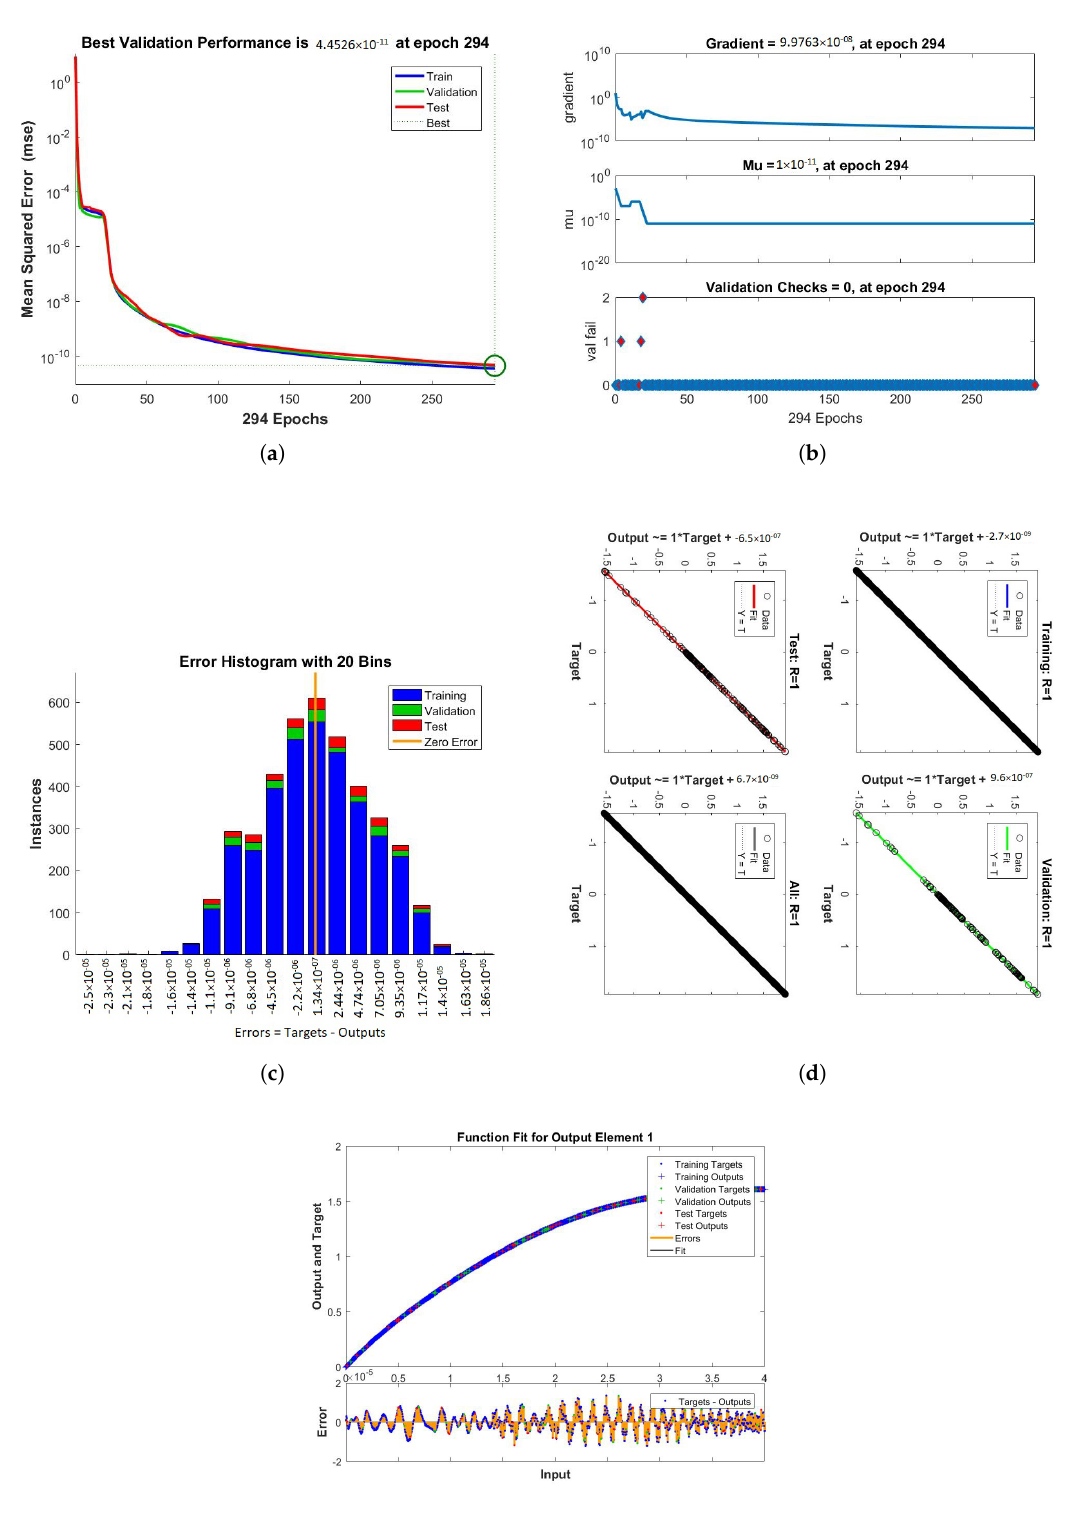
Figure 18. The figures clearly show the mean square error (mse), error histogram, gradient, Mu, validation checks, training, regression, and the epoch takes to reach the best results when φ =